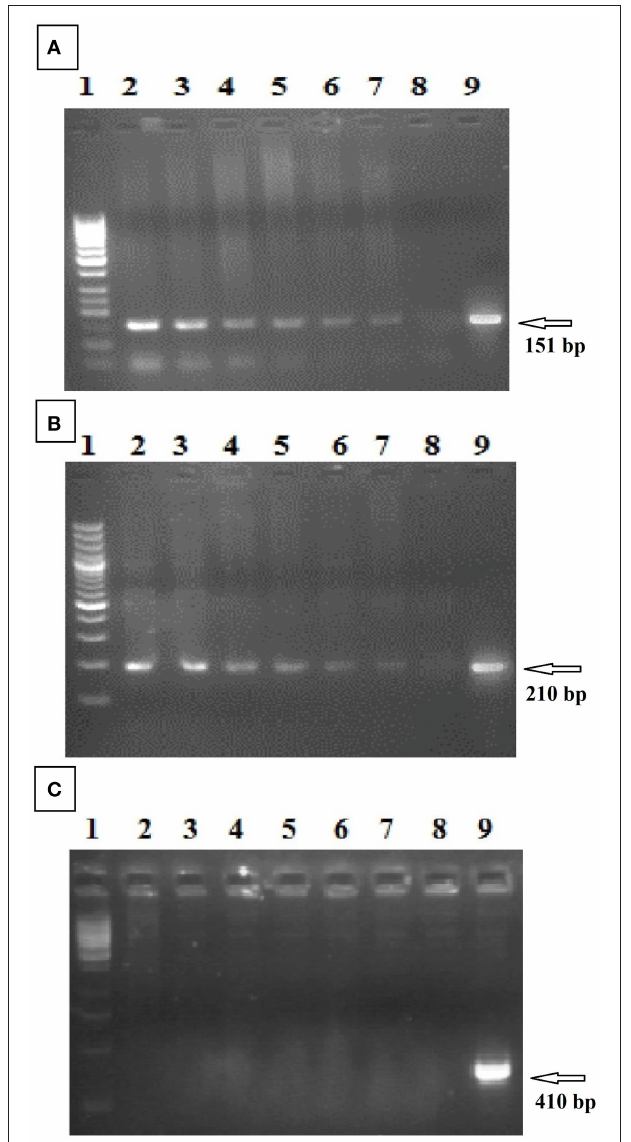
FIGURE 3 | PCR analysis of transformed cotton for NPTII gene, 35S CaMV promoter region, and VirG gene. (A) (NPTII gene): Lanes 2–7: putative transgenic cotton lines; lane 8: untransformed cotton, lane 9: pGA482- GhEXPA8 ; lane 1: 50bp DNA ladder (Fermentas, USA). (B) (35S CaMV promoter region): lane 1: 100bp DNA ladder (Fermentas, USA) Lanes 2–7: putative transgenic cotton lines; lane 8: untransformed cotton, lane 9: pGA482- GhEXPA8 . (C) (VirG gene of Agrobacterium ): lane 1: 1kb DNA ladder (Fermentas, USA) Lanes 2–7: putative transgenic cotton lines; lane 8: untransformed cotton, lane 9: pGA482- GhEXPA8